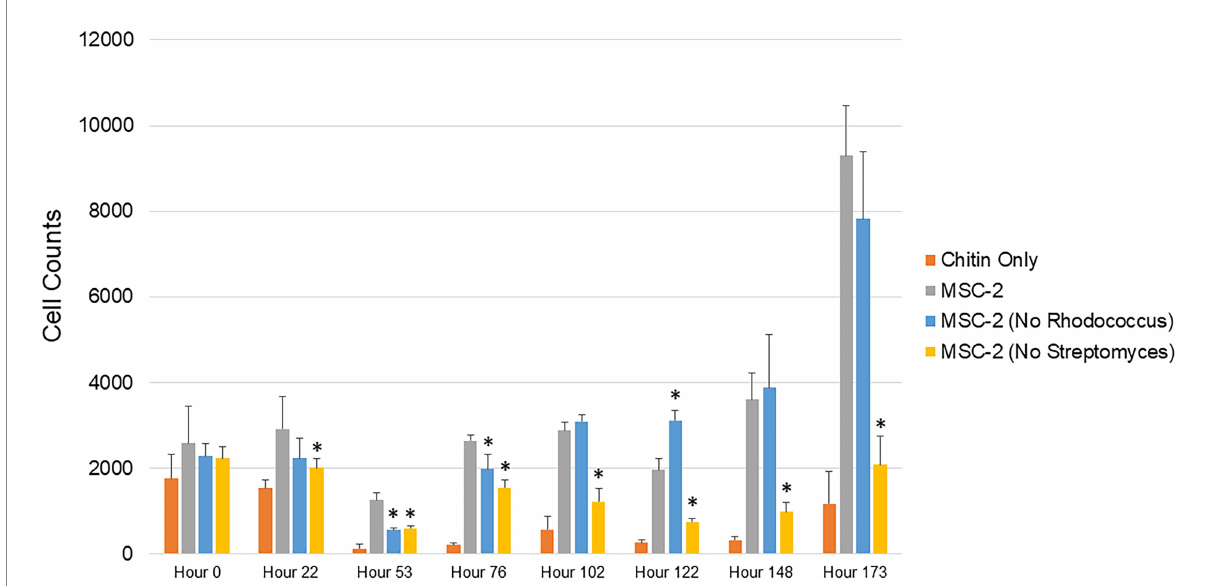
FIGURE 2 Cell counts of MSC-2 and MSC-2 subset communities during chitin growth. Cell counts are shown on the y-axis and timepoints ranging from 0 to 173 h are shown on the x-axis. Orange bars are uninoculated samples containing only chitin, grey bars are complete MSC-2 communities, blue bars are MSC-2-R communities (lacking Rhodococcus ), and yellow bars are MSC-2-S communities (lacing Streptomyces ). Error bars indicate standard deviation and asterisks indicate that the community is statistically different from the MSC-2 community at that timepoint with a p -value of less than 0.05 using a Student’s t -test.